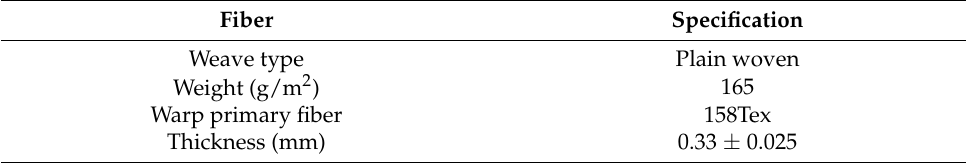
Table 1. Specification of aramid fiber based fabric.